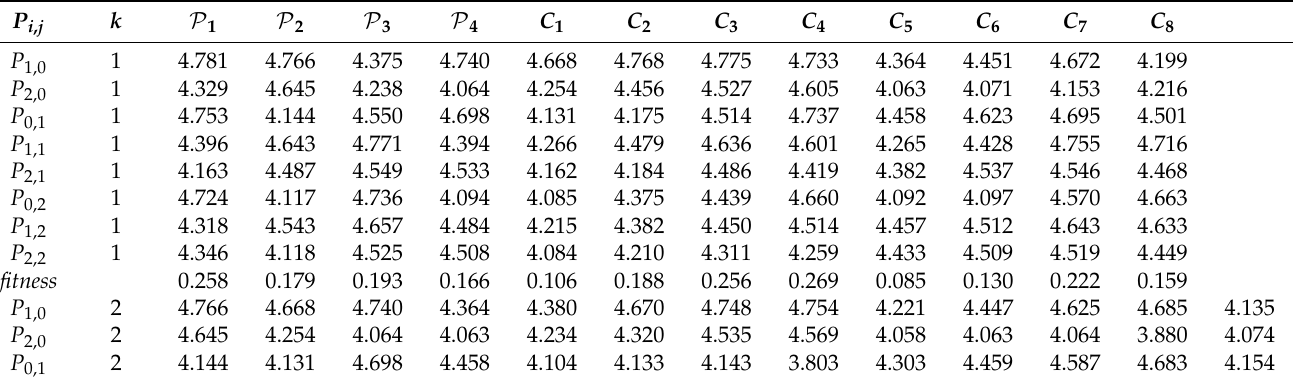
Table 1. Control points generated in the first and second generation.